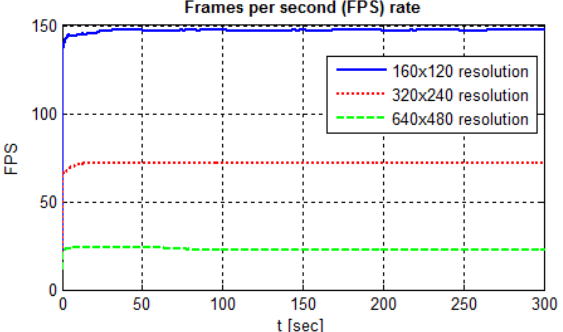
Figure 29. Frames per second rate per image